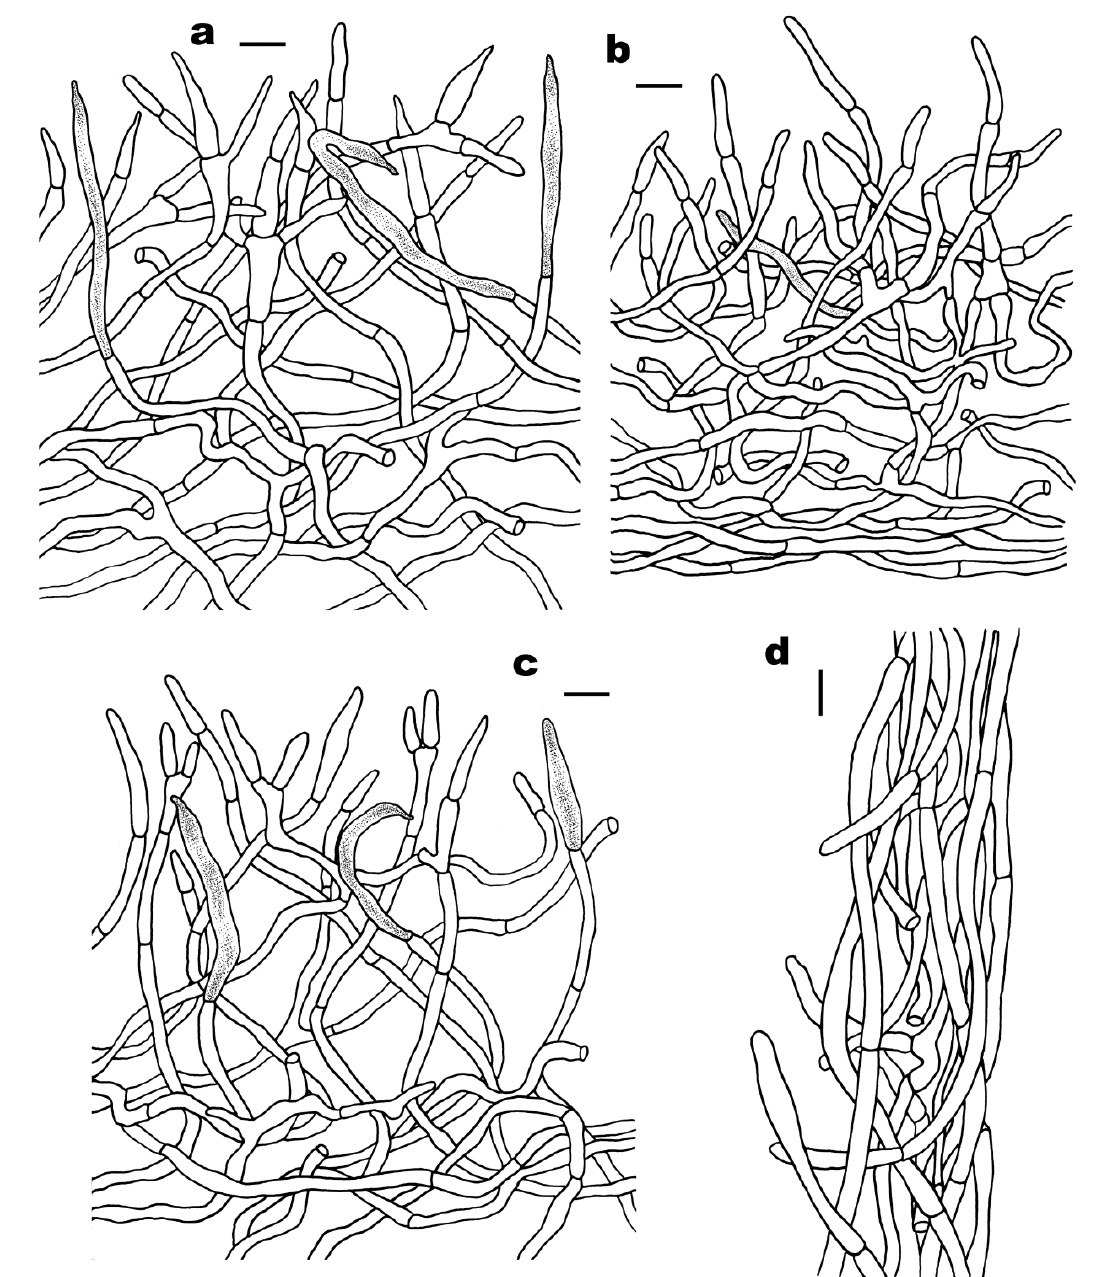
Figure 9. Microscopic features of Russula rufobasalis (FHMU827). ( a ) Pileipellis at pileus centre. ( b ) Pileipellis at middle part between center and margin of pileus. ( c ) Pileipellis at pileus margin. ( d ) Stipitipellis. Bars: 10 μm. Drawings by Y.X. Han.